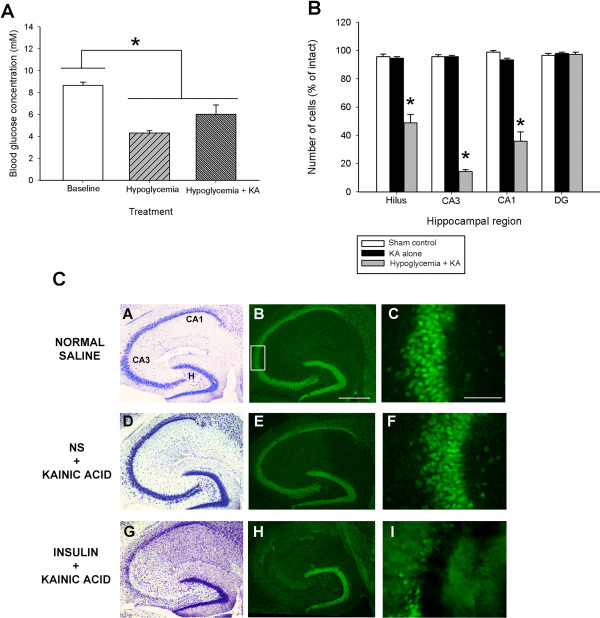
Glucose infusion suppresses neuronal damage following kainate-induced status epilepticus damage. (A) Blood glucose concentration was decreased significantly 3 hours after insulin injection and after insulin + kainate injections. Data represent the mean ± S.E.M. of at least 5 mice per condition. Asterisk indicates significant difference compared with any other group (ANOVA with post hoc Student Newman Keuls; F=16.57, P<0.001). (B) Quantitative analysis of neuronal density in hippocampal subfields following insulin injection + KA to B6 mice. Viable surviving neurons were estimated by cresyl violet staining. Bars denote the percentage of surviving neurons (as compared with saline-injected sham control B6 mice). Data represent the mean ± S.E.M. of at least 5 mice per condition. Asterisks indicate significant difference compared with KA alone or Sham control (ANOVA with post hoc Student Newman Keuls; F=99.70, P<0.001). (C) Insulin-induced hypoglycemia dramatically increased the extent of hippocampal cell death in B6 mice. Low-power photomicrographs of cresyl violet (A,D,G) and NeuN-stained (B,E,H) horizontal sections of the hippocampus showing differential cell loss 7 days after kainate-induced SE in a normoglycemic (NS + KA) and hypoglycemic (insulin + KA) mouse. Note that extensive kainate-induced cell loss, as evidenced by loss of cresyl violet staining (G) and NeuN immunostaining (H), is only observed in the dentate hilus, areas CA3 and CA1 following insulin pre-treatment in excitotoxin cell death resistant (B6) mice. CA1 and CA3 denote the hippocampal subfields; H, dentate hilus. Scale bar = 750 μm (A,C); 100 μm (B,D). High-magnification photomicrographs represent details of the boxed area of CA3 shown in B.